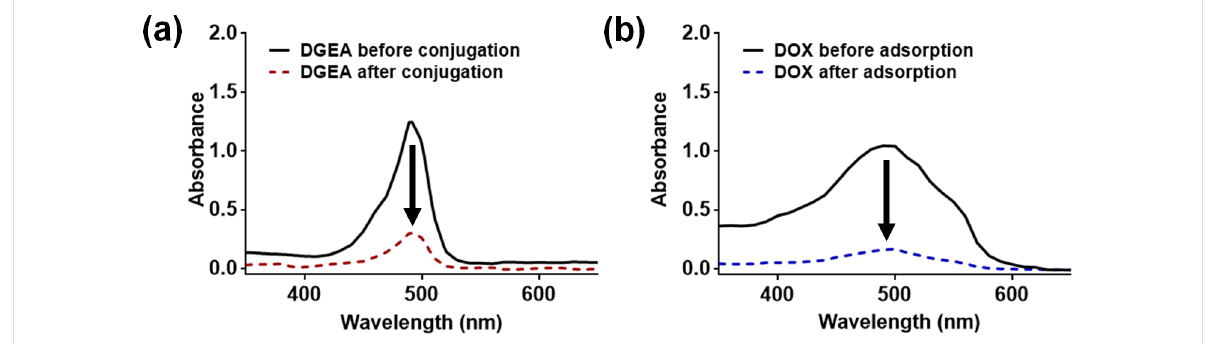
Figure 1: Absorbance spectra for (a) DGEA before and after conjugation with ND and (b) DOX before and after adsorption to ND-DGEA conjugates. 100 µg of DGEA was added prior to conjugation, and about 25 µg remained in the supernatant. Approximately 100 µg of the added 500 µg DOX remained in the supernatant after facilitating adsorption to ND-DGEA.